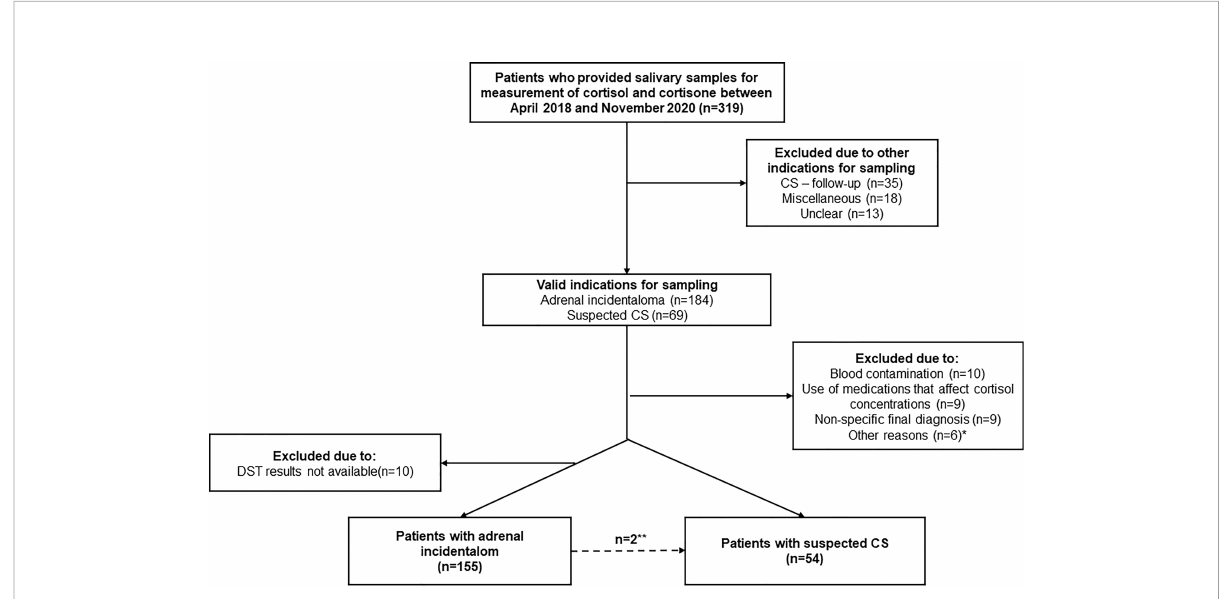
FIGURE 1 Summary of the study population, 319 patients who provided salivary samples for measurement of cortisol and cortisone between April 2018 and November 2020. * Including one patient with pheochromocytoma, one with primary aldosteronism, one with iatrogenic CS, ** Two patients with adrenal incidentaloma had clinically overt CS and were included in the analysis of patients with suspected